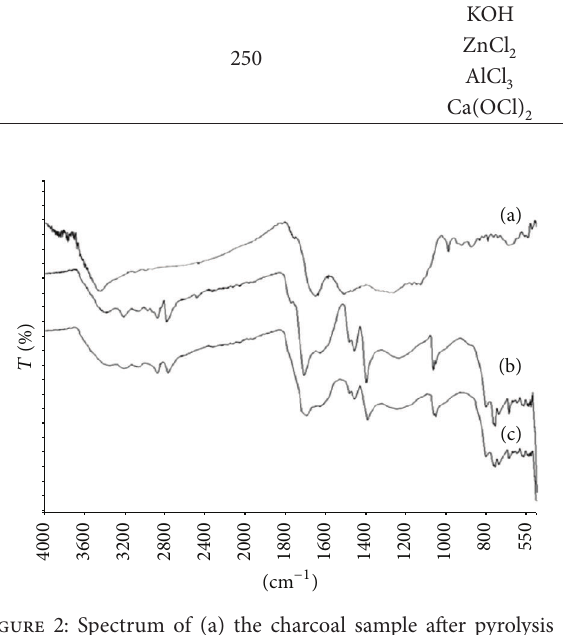
Figure 2: Spectrum of (a) the charcoal sample after pyrolysis at 250 ∘ C, (b) the chemically treated AC followed by pyrolysis at 250 ∘ C, and (c) the Pb(II)-loaded AC.